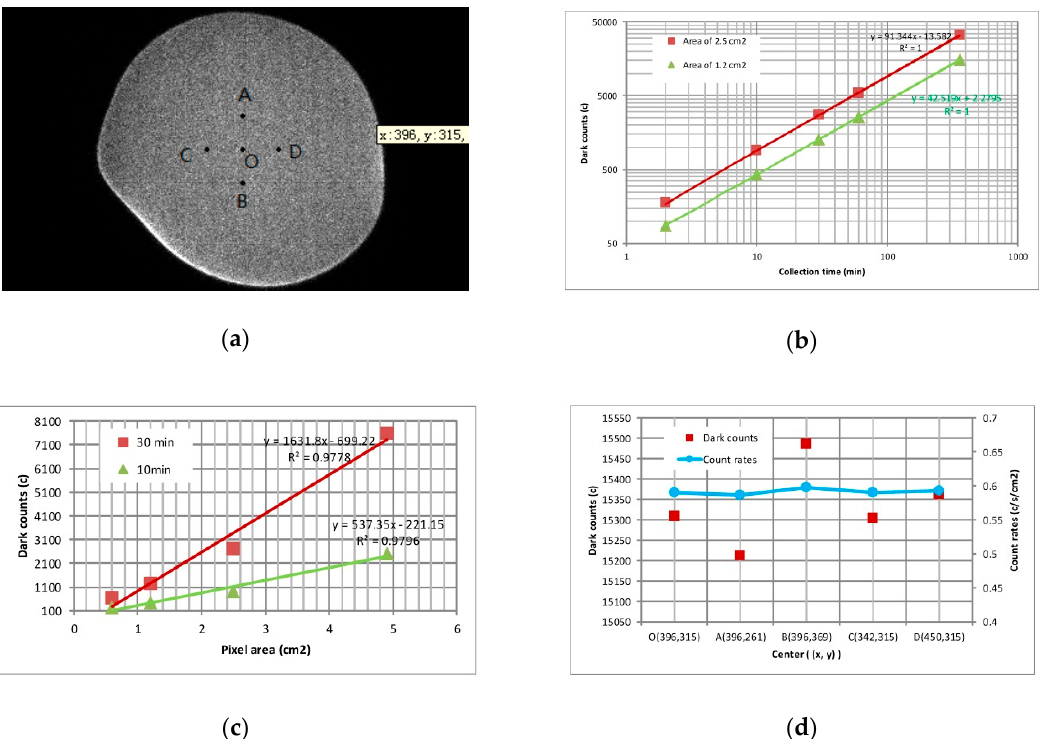
Figure 13. Statistical characteristics of dark counts: ( a ) continuous collection for 360 min on a dark background; ( b ) dark counts variance over collection time; ( c ) dark counts changes with di ff erent pixel areas; ( d ) dark counts in the same area with di ff erent center points. The selected area should avoid the edge of the image because the edge is distorted.